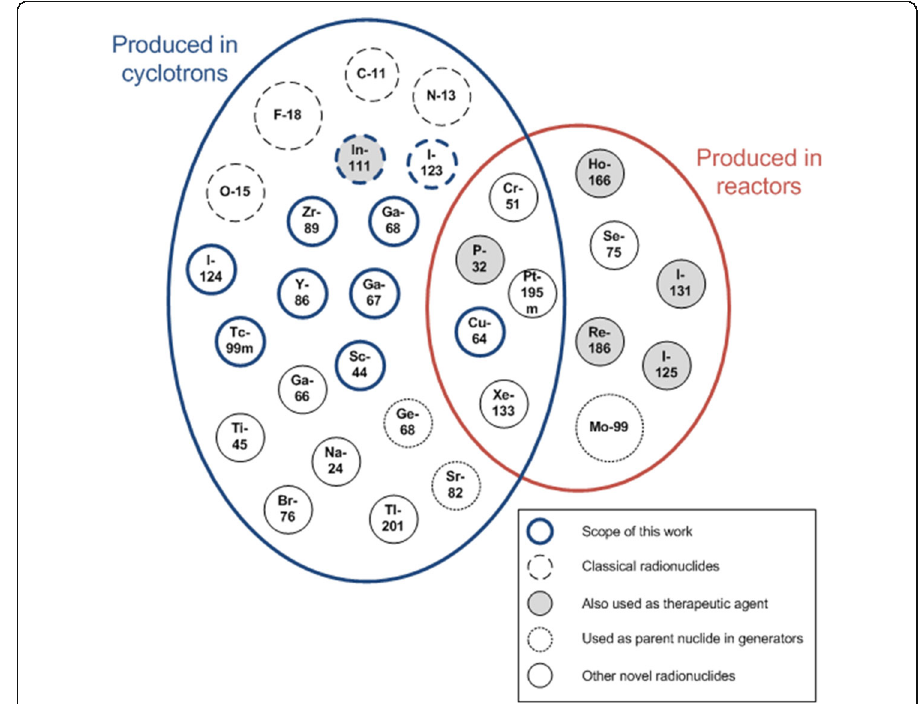
Fig. 1 Radionuclides used in nuclear medicine